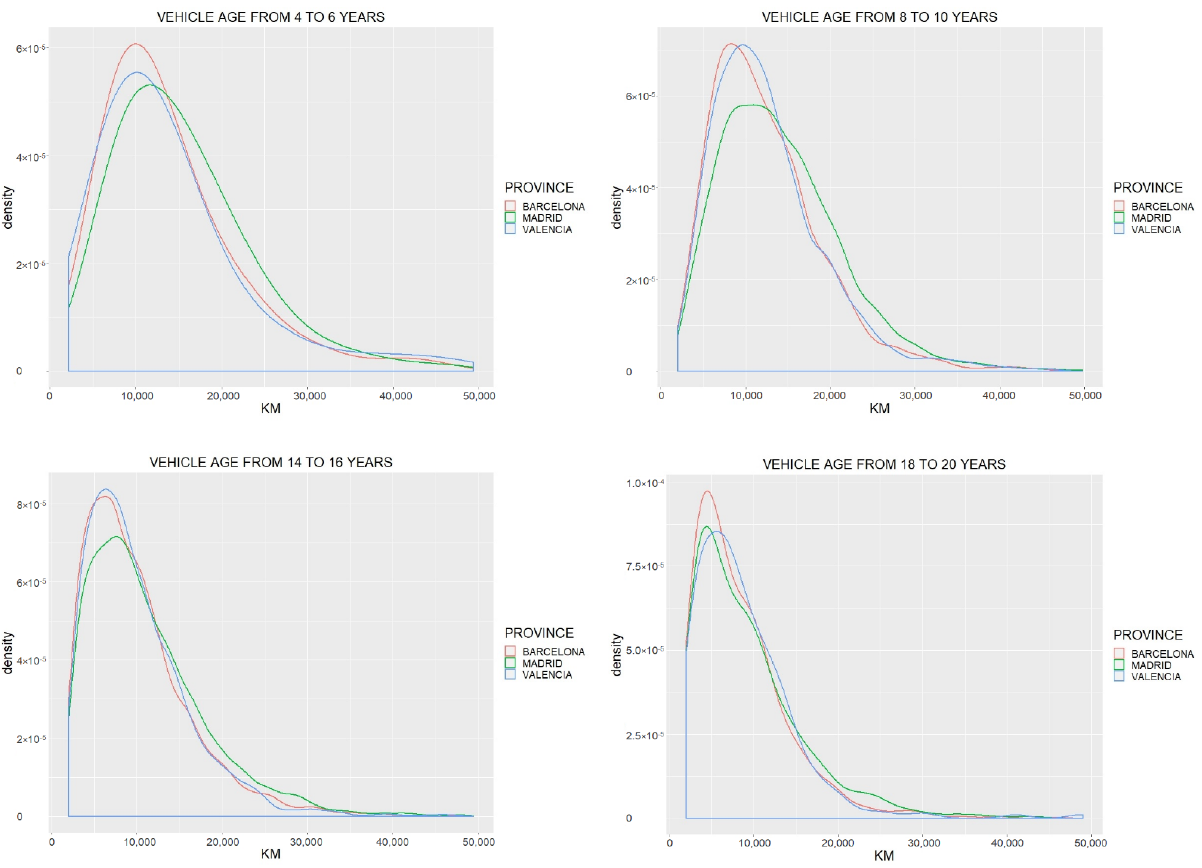
Figure 5. Comparison of kilometers per year for the provinces of Barcelona, Madrid, and Valencia, in relation to vehicle age.